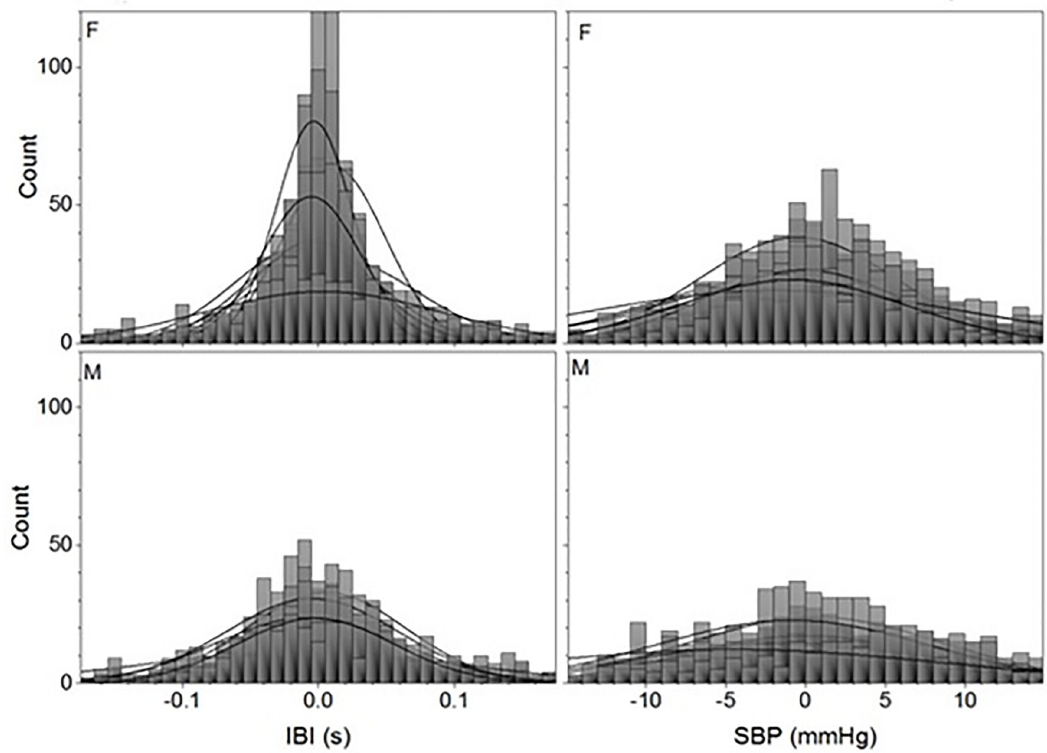
Fig 1. Histograms of detrended time series for achalasia patients standing up. IBI records (left-hand panels) and SBP (right-hand panels) for all 9 female (F) (upper row) and all 5 male (M) (bottom row) patients are shown with the best normal distribution fit (continuous lines).